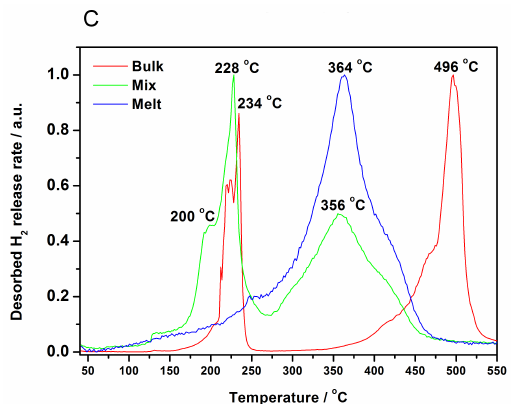
Figure 2. ( A ) Thermal programmed desorption mass spectroscopy (TPD-MS) profiles of the hydrogen release (H 2+ ions, m / e = 2); ( B ) thermogravimetric analysis (TGA); and ( C ) differential scanning calorimetry (DSC) measurements of bulk 2LiBH 4 -NaAlH 4 (LiNa) (red), LiNa mixed with carbon aerogel scaffold (CA) (green) and LiNa melt infiltrated into CA (blue). The data is measured in the temperature range 40 to 550 ˝ C and TPD-MS for each data set is normalized by its maximum hydrogen release rate to allow for qualitative comparison ( ∆ T / ∆ t = 10 ˝